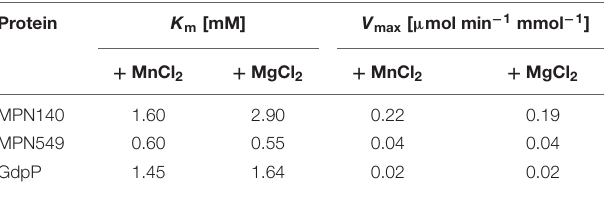
TABLE 1 | Kinetic parameters for phosphodiesterase activity on bis-pNPP. Protein